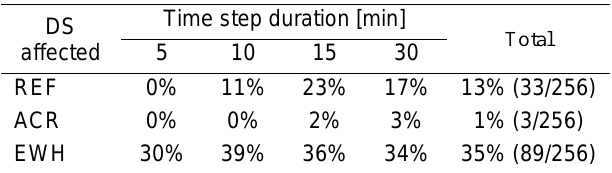
Table 3. Share of problems in which the removal of state variables in select DSs improved computational performances, in total and by time step duration.